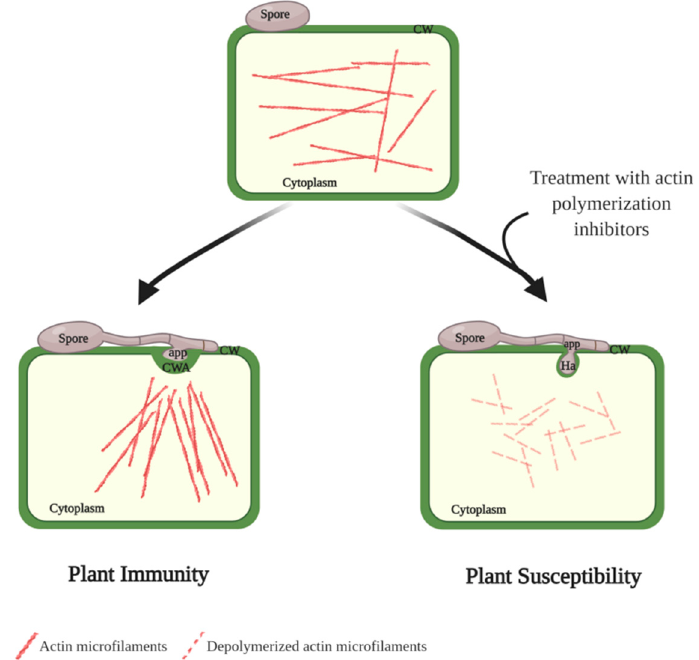
Figure 1. Reorganization of actin microfilament in response to pathogen infection. In non-attacked host cells, actin microfilaments form a homogenously dense and distributed network in the cytoplasm. Upon perception of attempted penetration by the pathogen, microfilaments increases in density and aggregates towards the penetration site. Actin focusing is required for rapid trafficking of cytoplasmic components, culminating in the establishment of cell-wall reinforcements. Treatment of leaves with inhibitors of actin polymerization has been shown to compromise cytoplasmic aggregation and suppress callose deposition and papillae formation, leading to increase susceptibility to pathogen infection. app, appressorium; CW, cell wall; CWA, cell wall apposition; Ha, haustorium (created with BioRender.com). Blumeria graminis f. sp. avenae ( Bga ), confocal scanning microscopy images revealed an